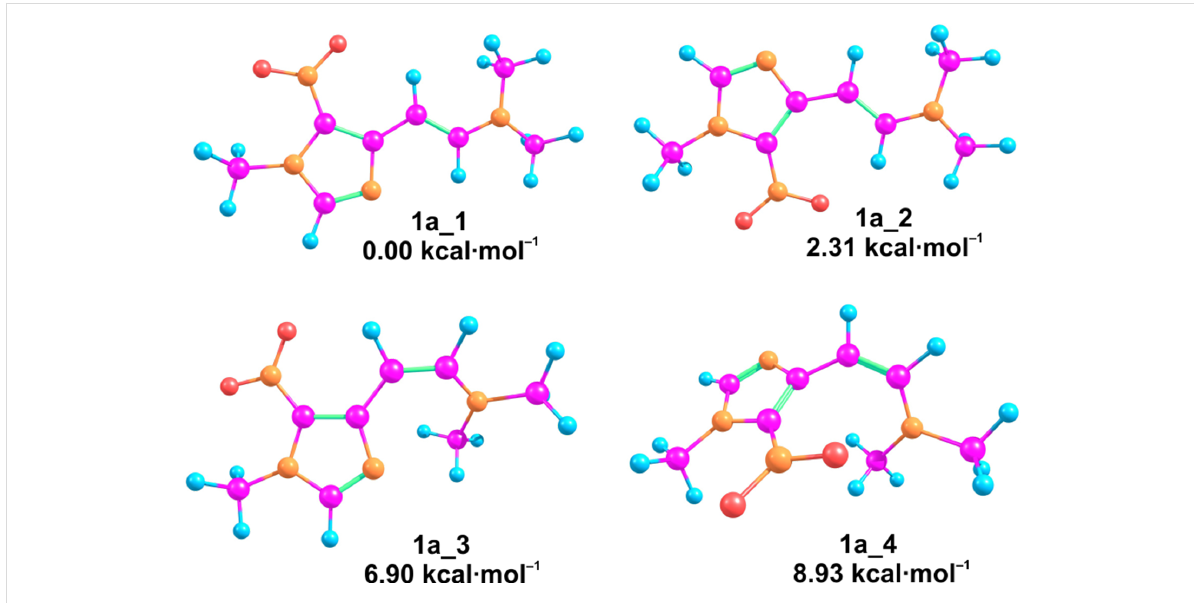
Figure 5: Geometries of enamine 1a appropriate to the calculated minima on the PES, and their relative free energies at 298.15 K in gas phase conditions.